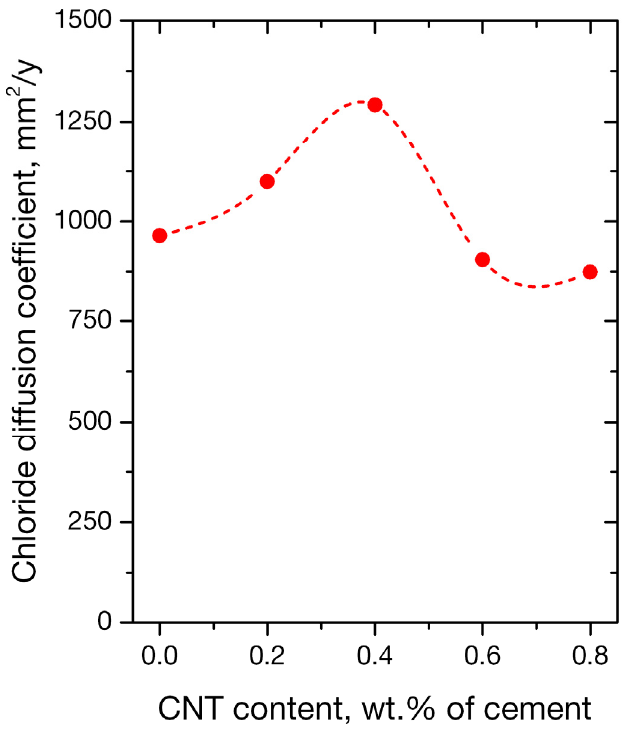
Figure 8. Chloride diffusion coefficient for each nano-modified mortar.